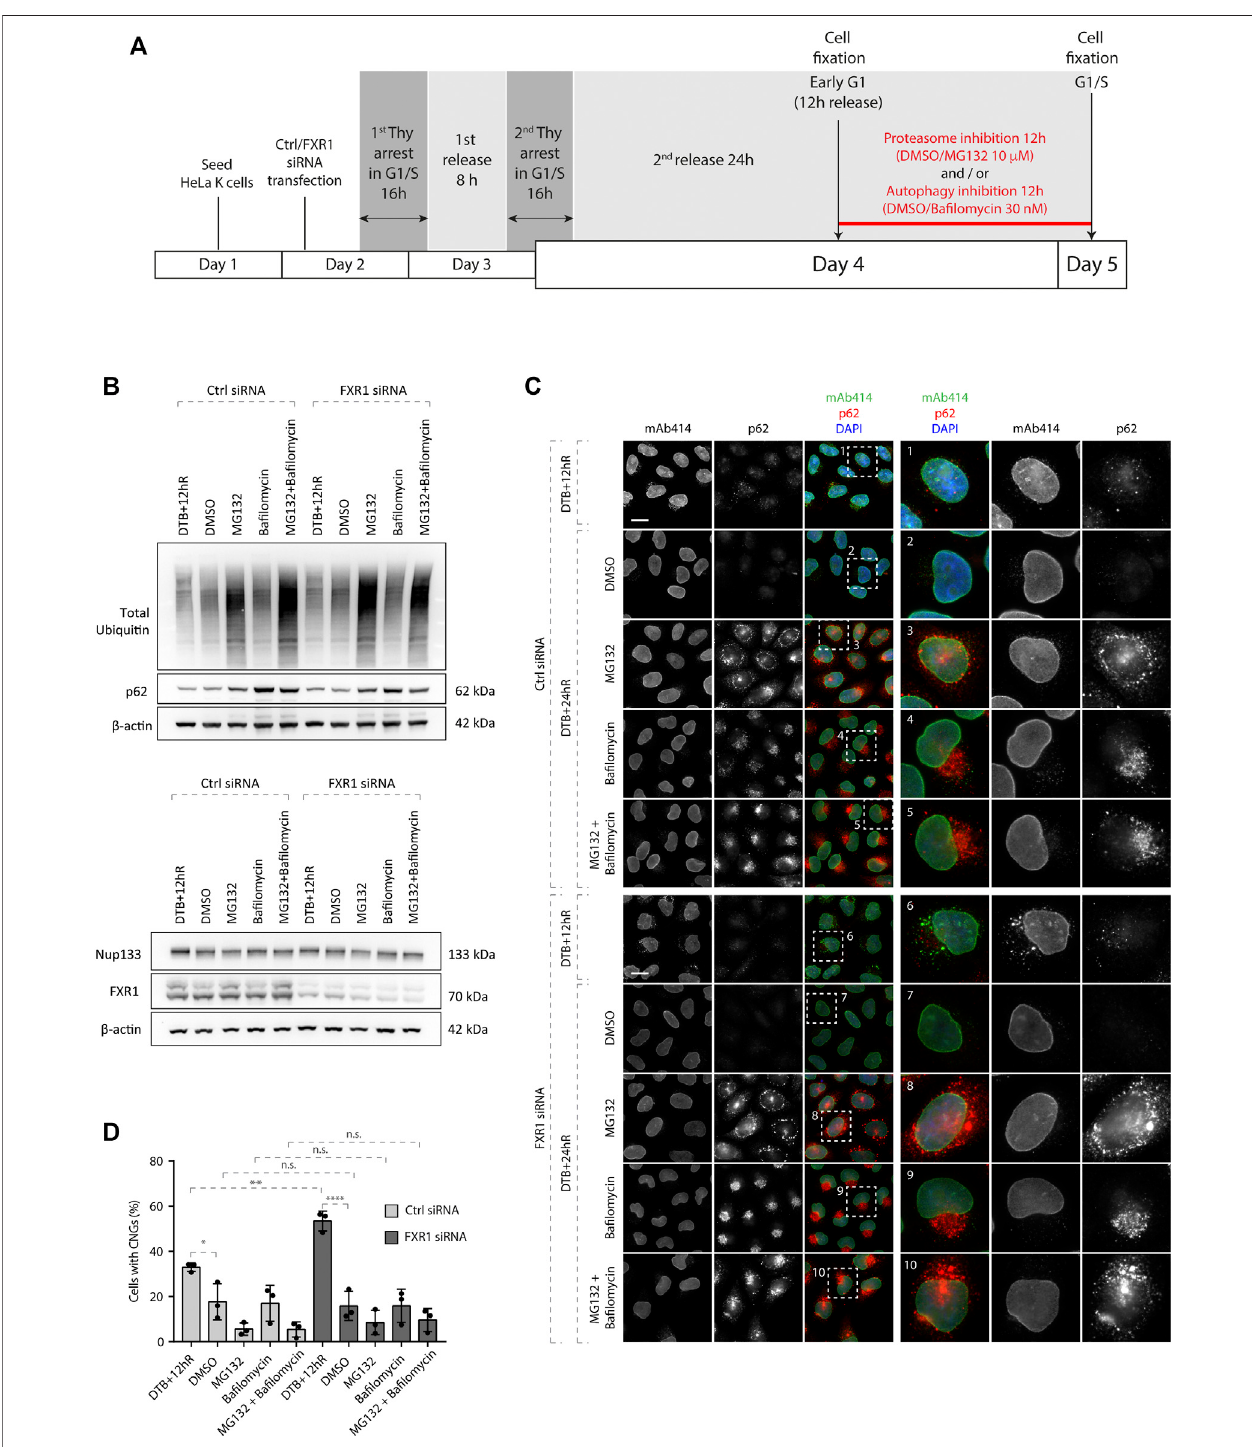
FIGURE 2 | CNGsinducedbyFXR1downregulationarenotclearedthroughproteasomeorautophagy. (A) Schemeoftheexperimentalsetup.HeLaKcellswereseeded oncoverslips,treatedwiththeindicatedsiRNAs,synchronizedbydoublethymidineblock,andreleasedfromG1/Sarrest.Twelvehoursafterrelease(whensynchronizedcellswere inearlyG1),thecellswereincubatedwiththeproteasomeinhibitor(10µMMG132)and/orautophagyinhibitor(30nMba fi lomycin)orthevehicle(DMSO)foradditional12h.During the last 90 min, Nup granules were induced by the addition of nocodazole or the vehicle (DMSO) in the presence of translational inhibitors. Subsequently, the cells were analyzed by Western blotting (B) and immuno fl uorescence microscopy (C, D) . (B) Whole cell lysates from cells treated as in (A) were analyzed by Western blotting. (C, D) Cells treatedasin (A) wereanalyzedbyimmuno fl uorescencemicroscopy( C )andthepercentageofcellswithcytoplasmicnucleoporingranules(CNGs)wasquanti fi ed. (D) 7,100cells were analyzed (mean ± SD, * p < 0.05; ** p < 0.01; and **** p < 0.0001; n.s. (cid:1) non-signi fi cant, N (cid:1) 3). The magni fi ed framed regions are shown in the corresponding numbered panels. Data information: scale bars are 5 μ m. Statistical signi fi cance was assessed by one-way ANOVA test with Sidak ’ s correction.